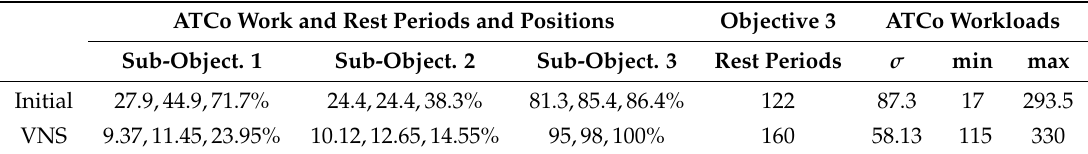
Table 1. Objective functions in the initial and optimal solution in Instance